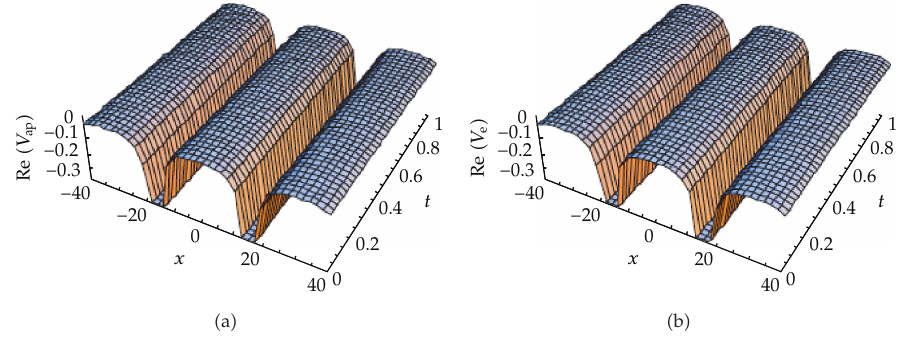
Figure 4: The approximate solution (cid:2) 5.20 (cid:3) shown in (cid:2) a (cid:3) in comparison with the exact solution (cid:2) 5.15 (cid:3) shown in (cid:2) b (cid:3) if k (cid:7) 0 . 1 ,c (cid:7) 0 . 2 , ∝ (cid:7) 0 . 1.